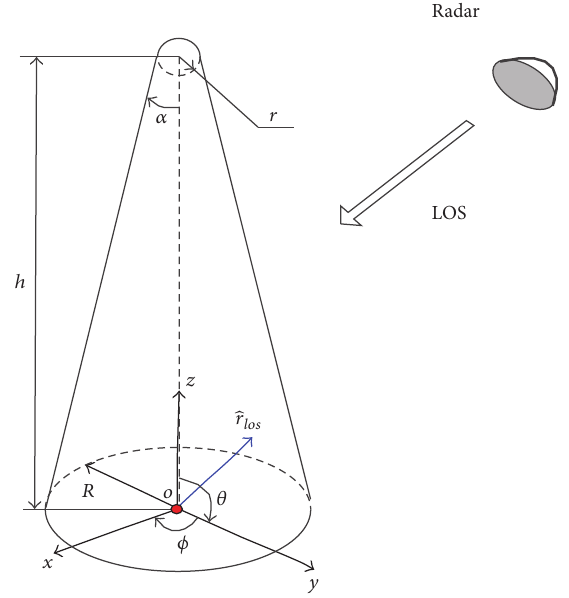
Figure 1: The geometry of the cone-shaped target and the